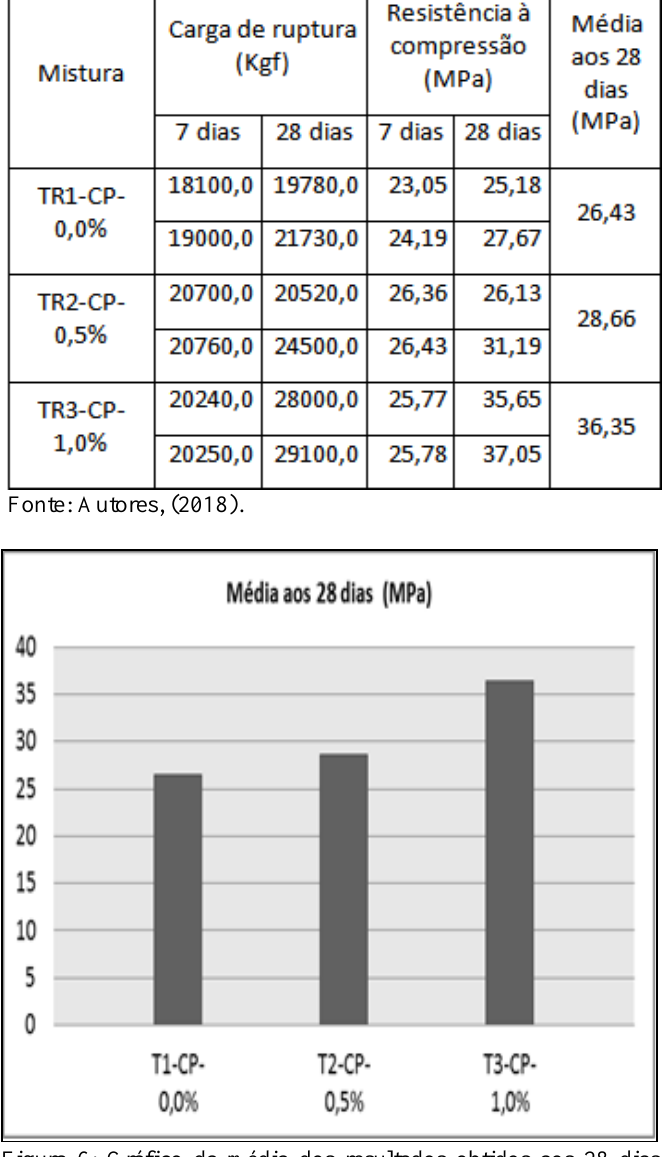
Figura 6: Gráfico da média dos resultados obtidos aos 28 dias. Fonte: Autores, (2018).